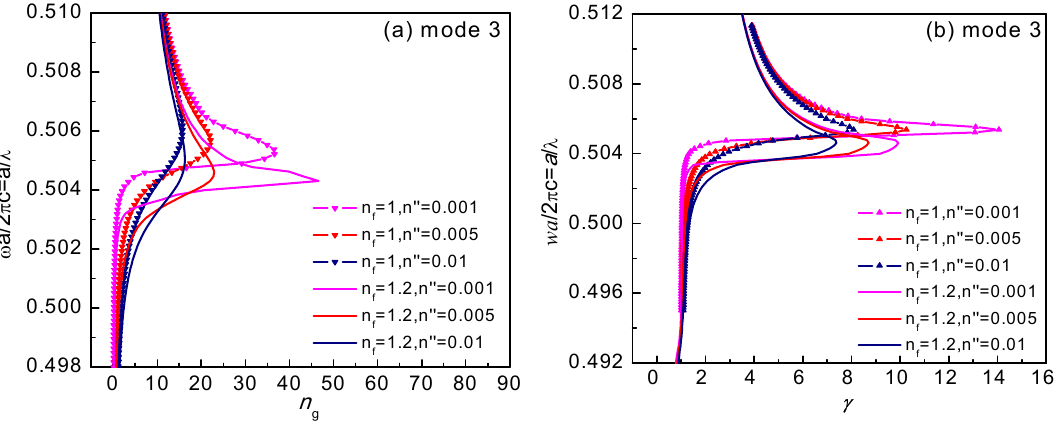
Figure 5. For mode 3, curves of ( a ) group index n g , and ( b ) absorption enhancement factor γ versus the normalized frequency.